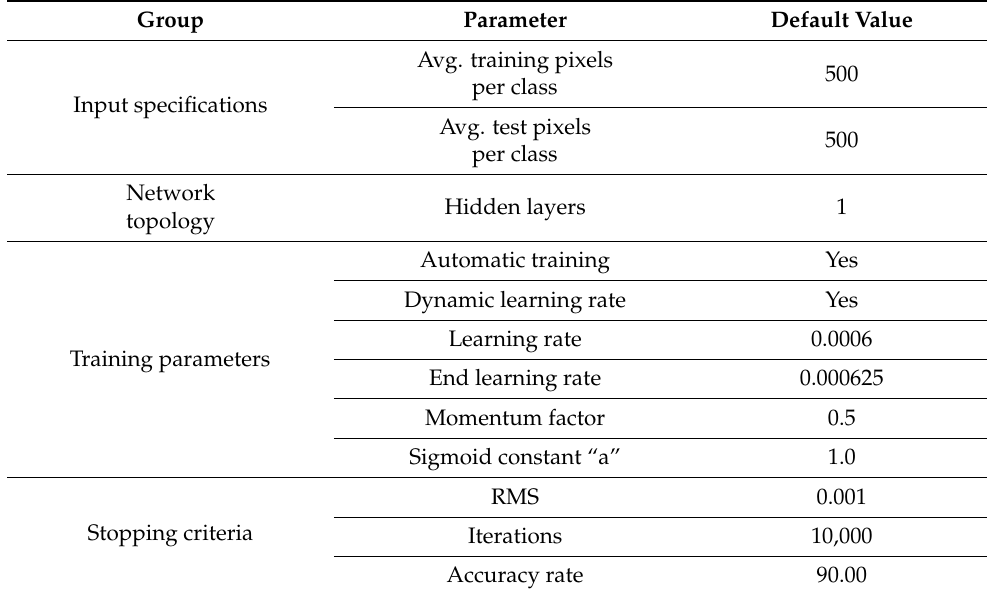
Table 2. Default characteristics and parameters of the ANN-MLP in the IDRISI